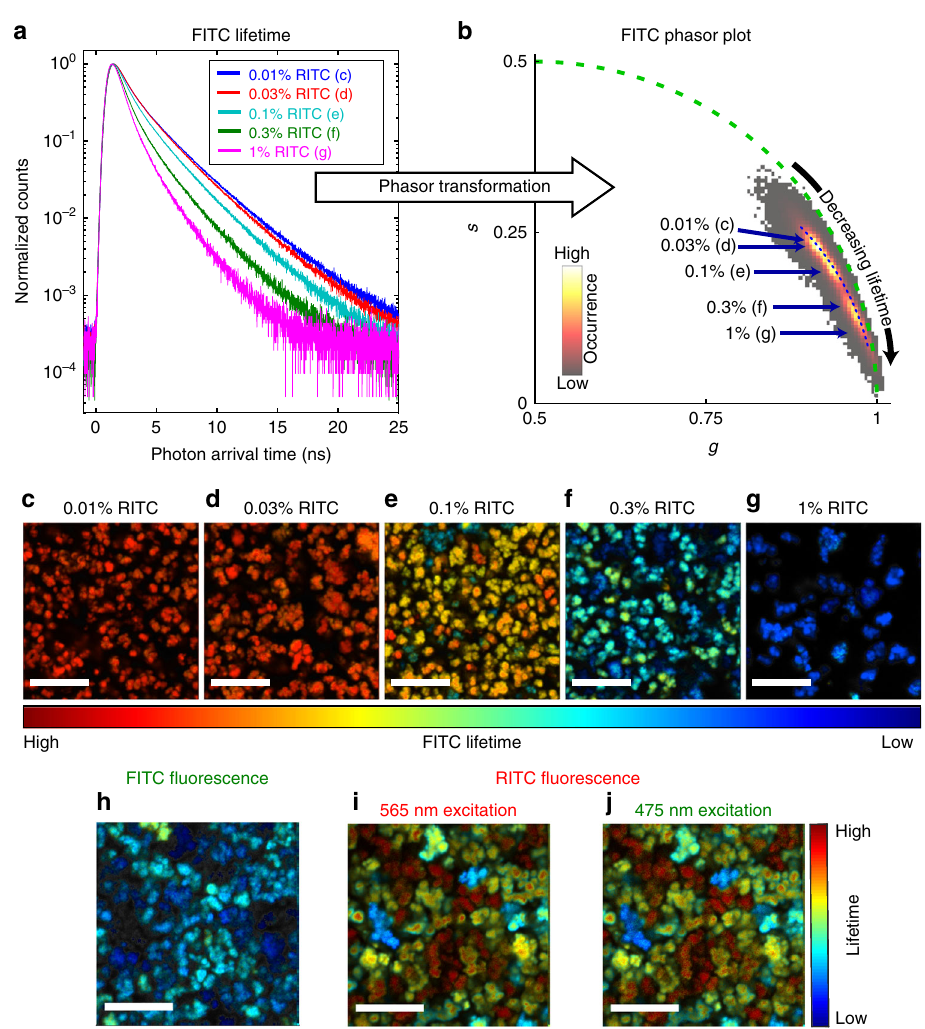
Fig. 2 A phasor analysis of UiO-67 samples with both FITC- and RITC-labeled linkers. The fraction of labeled linkers during sample preparation was held constant at 0.1% for FITC, whereas for RITC it was varied from 0.01% to 1%. a Photon arrival time histogram of the FITC fl uorescence for the full images shown in c – g . b The phasor histogram calculated from the pixel wise photon arrival time histograms of FITC of the images shown in c – g . The blue arrows point at the average phasor positions of the different samples. The green dotted line is the universal circle, indicating the possible positions of single exponential decays. c – g Lifetime images of FITC fl uorescence of UiO-67 samples with 0.1% input FITC linker fraction and 0.01% ( c ), 0.03% ( d ), 0.1% ( e ), 0.3% ( f ), or 1% ( g ) input RITC linker fraction. The color code represents the pixel phasor positions along the blue dotted line in b . h – j FLIM images for different excitation and detection schemes of the UiO-67 sample with 0.1% FITC and 1% RITC input fraction. The corresponding phasor plot is shown in Supplementary Fig. 4. h FLIM image of the green detection channel (500 – 540 nm) after 475 nm excitation, corresponding to the direct FITC fl uorescence. i FLIM image of the red detection channel (570 – 620 nm) after 565 nm excitation corresponding to the direct RITC fl uorescence. j FLIM image of the red detection channel after 475 nm laser excitation representing the possible FRET signal. The scale bar in all images is 10 µ